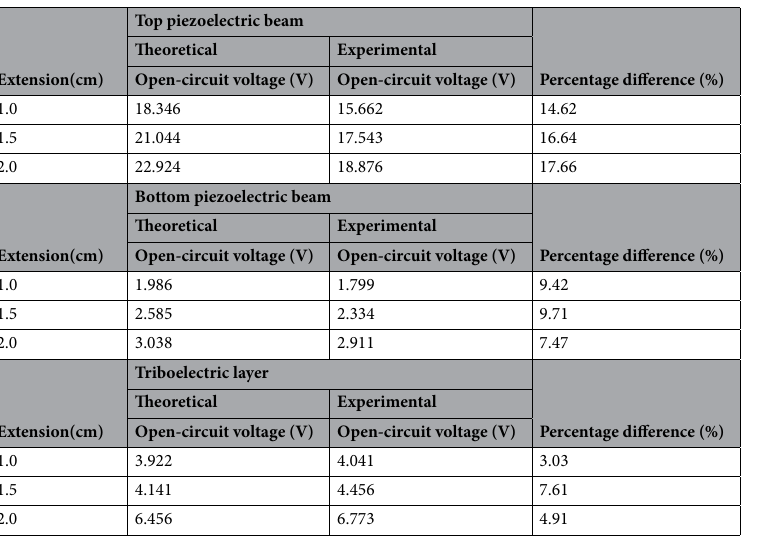
Table 3. Theoretical and experimental voltages from the top piezoelectric beam, bottom piezoelectric beam, and triboelectric mechanism for different extension lengths.